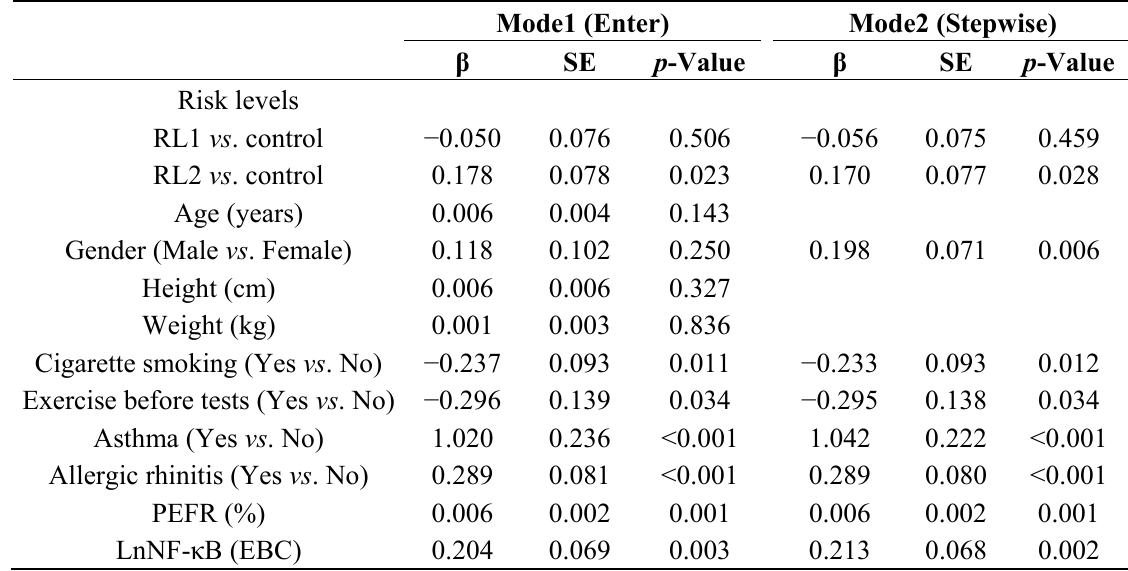
Table 3. Multiple linear regression model for determinants of fractional exhaled nitric oxide (FENO) values a